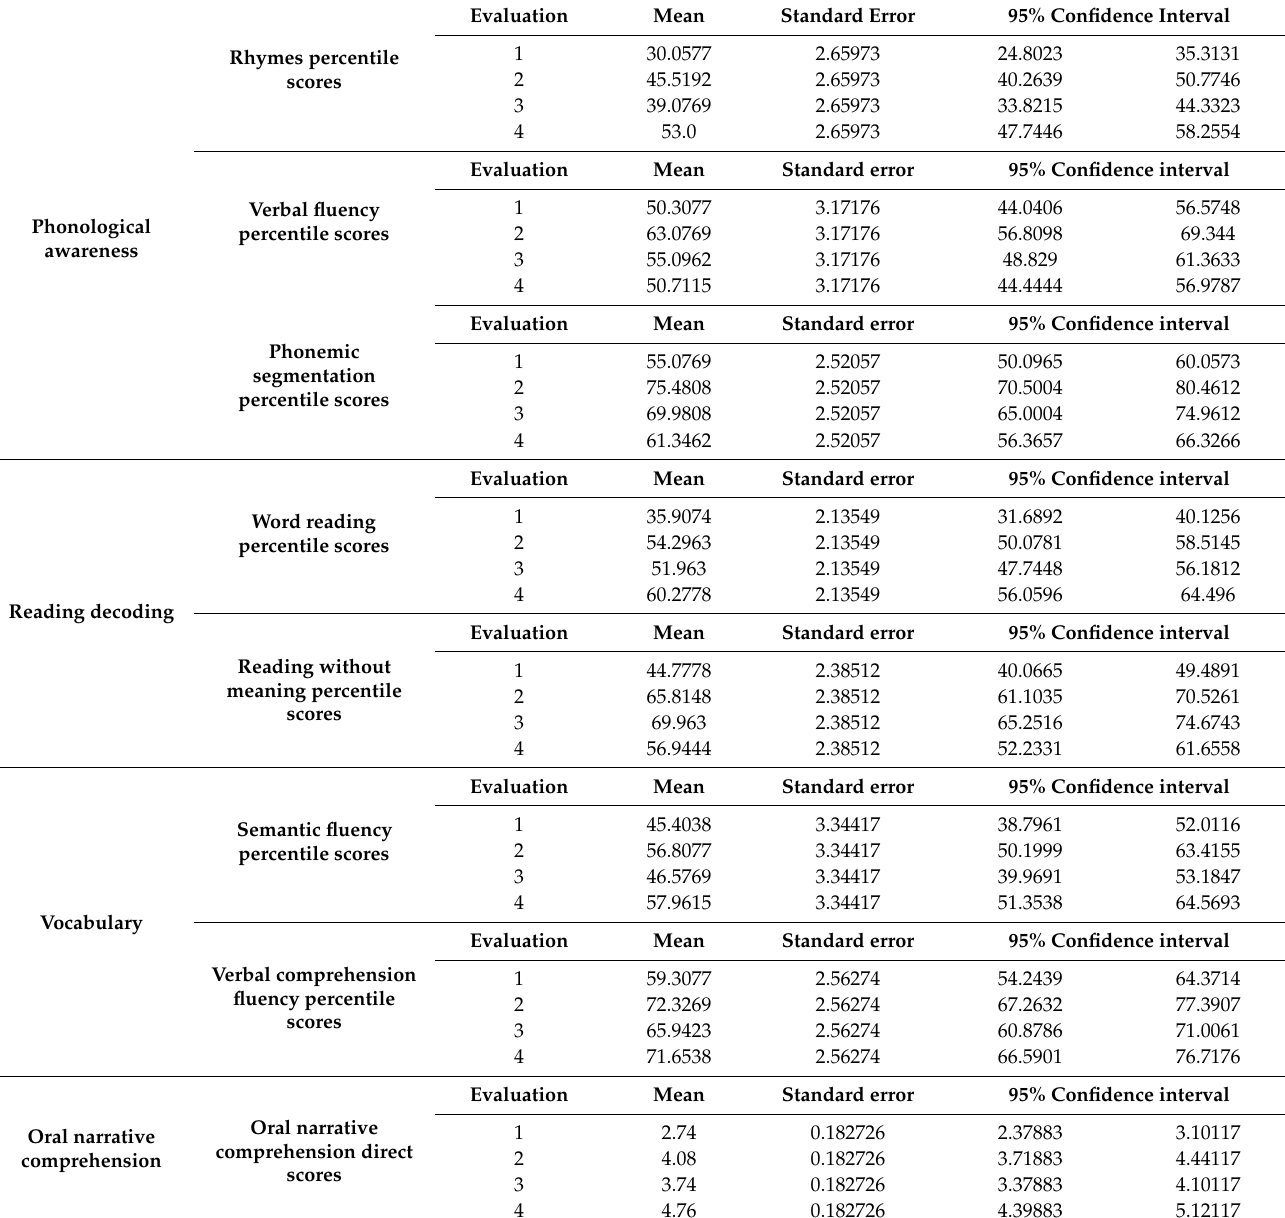
Table 3. Means of minimum squares for each variable (95% confidence